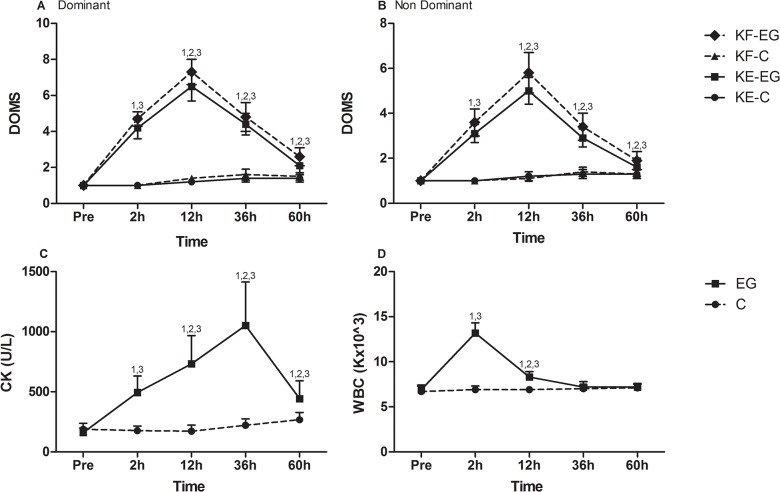
Changes of soreness (A-B), CK activity (C) and leukocyte counts (D) following a football match.MS, muscle soreness; CK, creatine kinase activity; h, hours; C, control group; EG, experimental group; KE-C, knee extensors of control group; KE-EG, knee extensors of experimental group; KF-C, knee flexors of control group; KF-EG, knee flexors of experimental group; 1Significant difference with baseline; 2significant difference between groups; 3significant difference between dominant and non-dominant limb at corresponding time; 4greater decline in functional ration compared to conventional ratio at corresponding time;5greater decline at 180°/s compared to that at 60°/s at corresponding time.